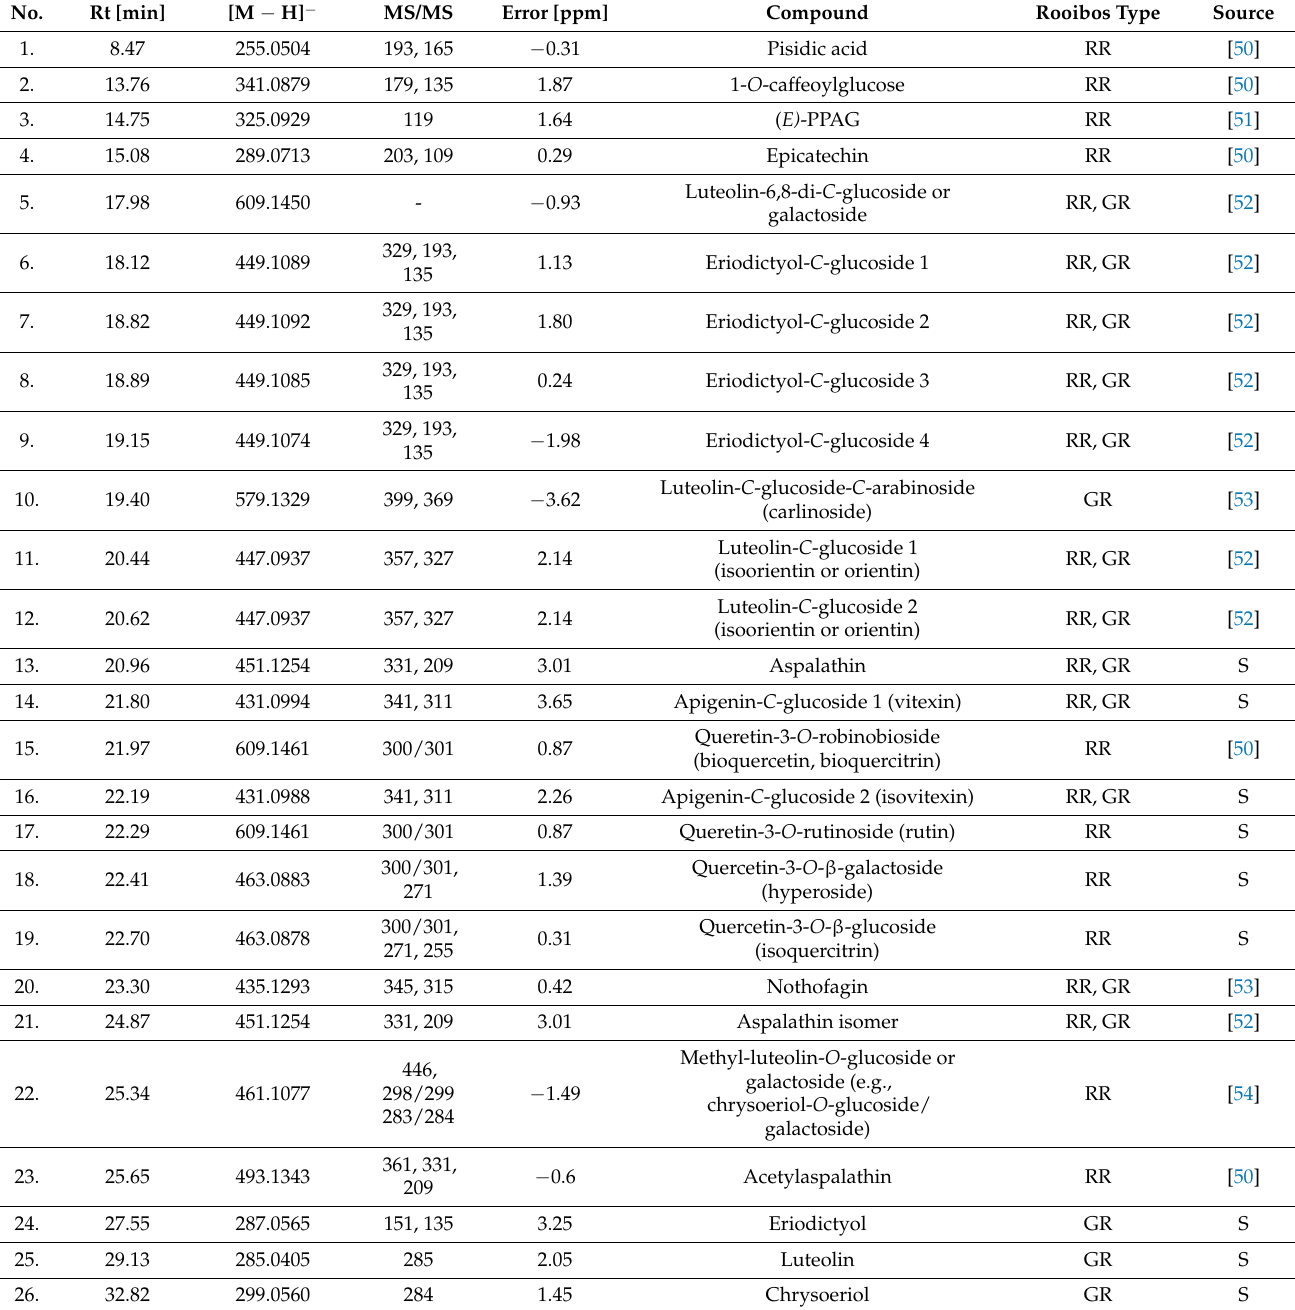
Table 1. UHPLC–ESI–MS data of red (RR) and green rooibos (GR) components in negative ion